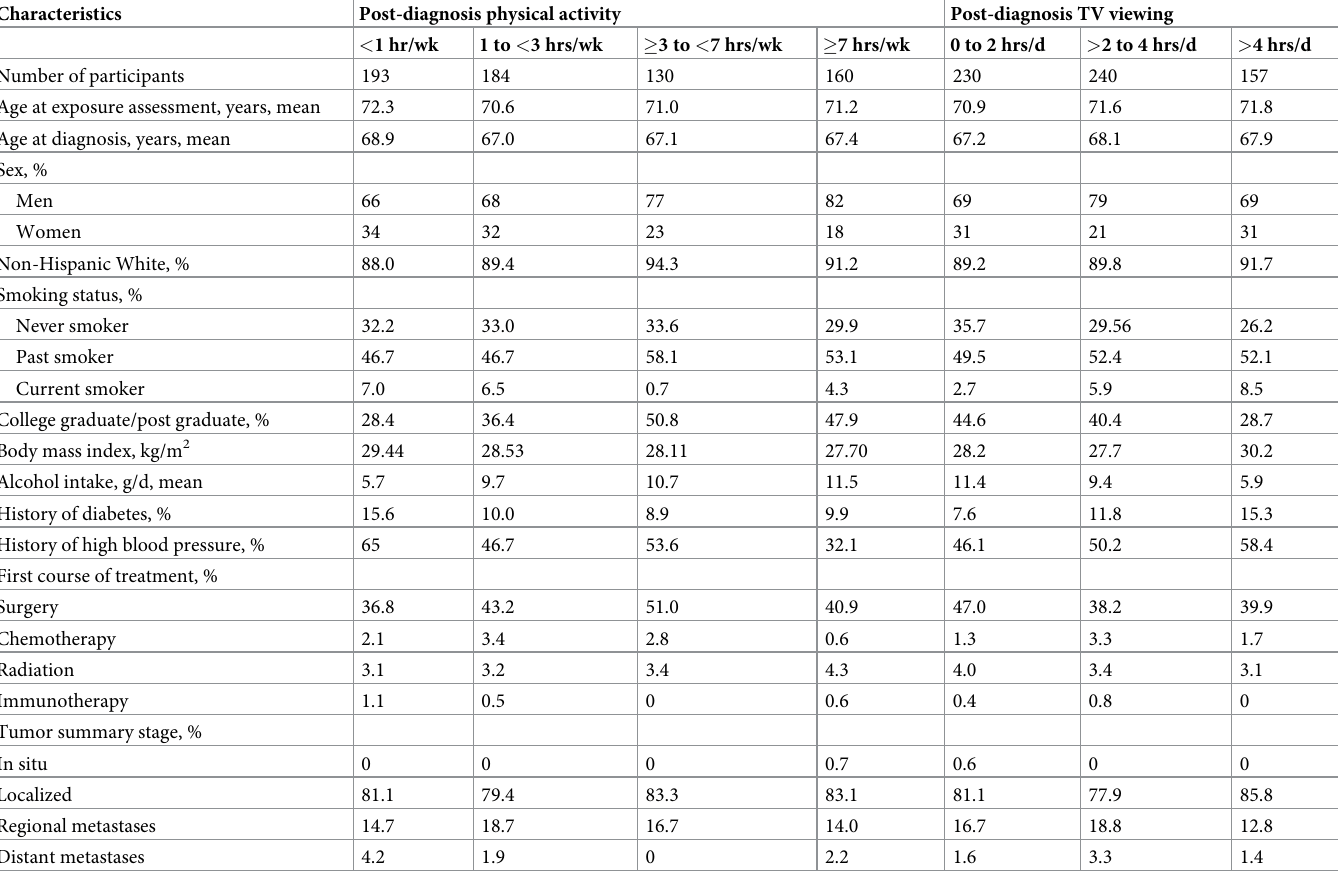
Table 1. Baseline characteristics of study participants diagnosed with incident renal cell cancer according to increasing levels of post-diagnosis moderate to vigor- ous physical activity and TV viewing.